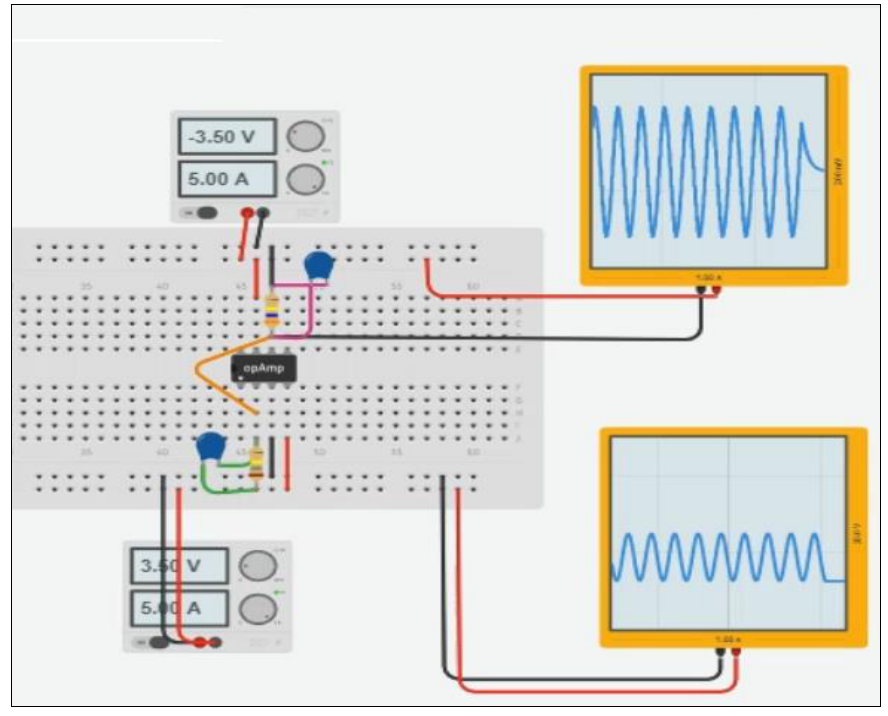
Figure 4: Lag Compensator using opamp circuit.